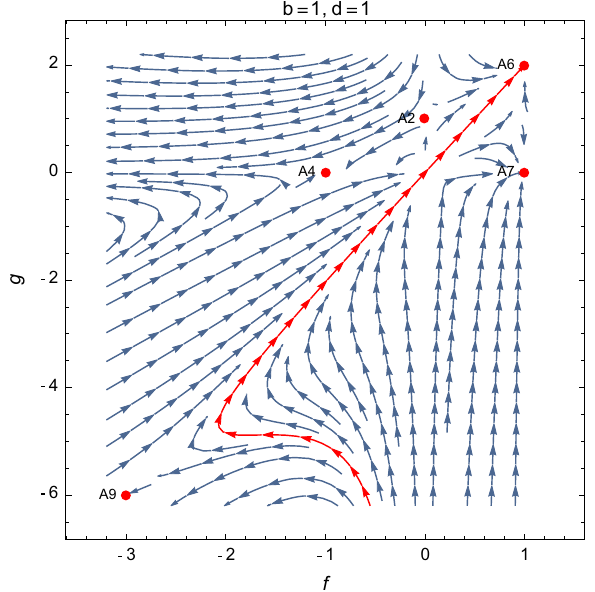
Fig. 3 Theprojectionofthephaseportraitofthemodelonthe fg -plane for the standard non-minimal coupling h ∝ φ 2 and the GB coupling η ∝ φ 2 ( b = 1, d = 1), with w m = 0. The point A2 is unstable on this plane and corresponds to the transition between decelerated and accelerated regimes. The de Sitter solution for the point A5 is stable on this plane, and in the case b > 1 and c < 1 + b , it is an attractor that could describe the final stage of a vacuum-dominated